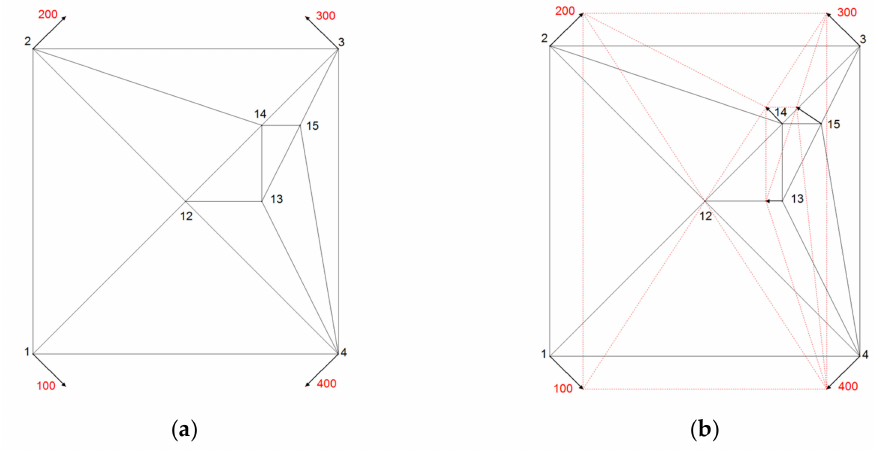
Figure 4. ( a ) Theoretical geometric setting and ( b ) the e ff ect of the proximity fitting with membrane model based on Hooke’s